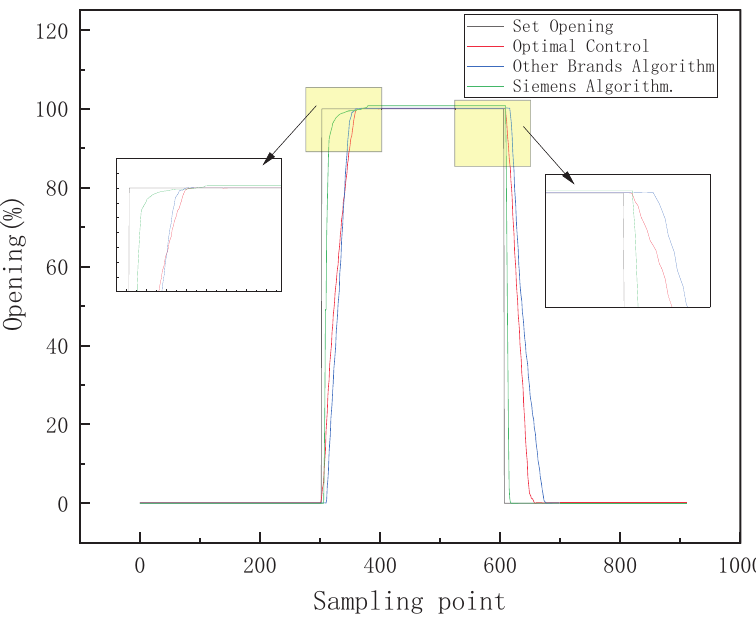
Figure 21. Full-stroke control algorithms